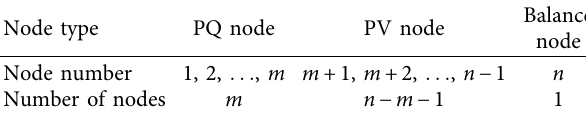
Table 1: Node number of power subsystem.